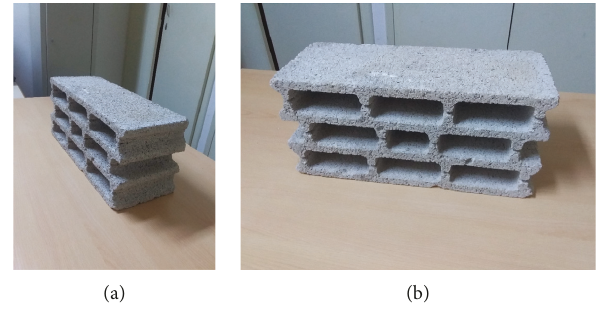
Figure 13: Photo of the block floor prototype. Table 9: Properties of lightweight concrete block floor. Concrete Figure 14: Punching-flexural test on the lightweight concrete block